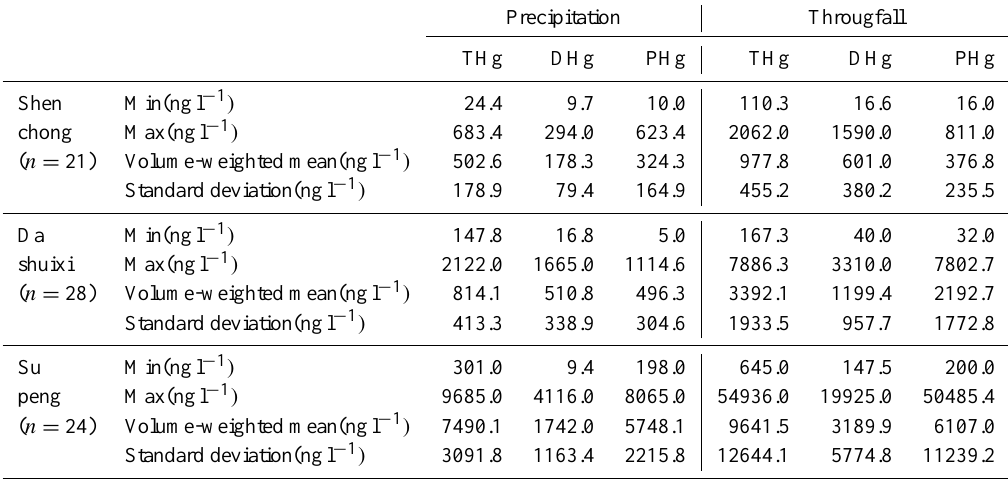
Table 1. Statistical summary of observed concentrations of mercury species in precipitation and throughfall samples collected at the three sites Supeng, Dashuixi and Shenchong from May 2010 to May 2011.